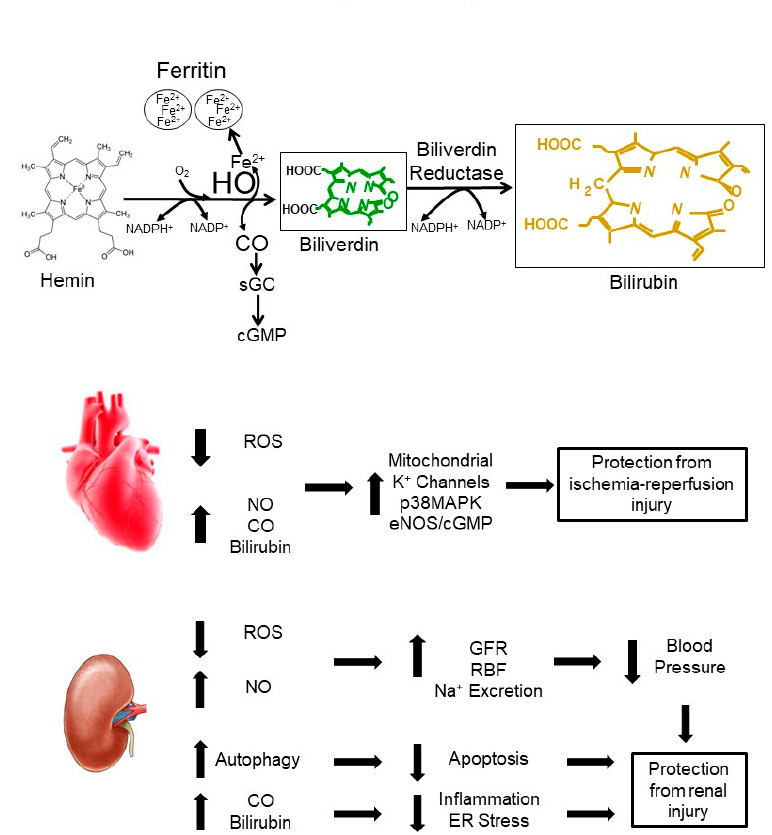
Figure 1. Proposed mechanisms by which HO and its metabolites confer cardio-renal protection.